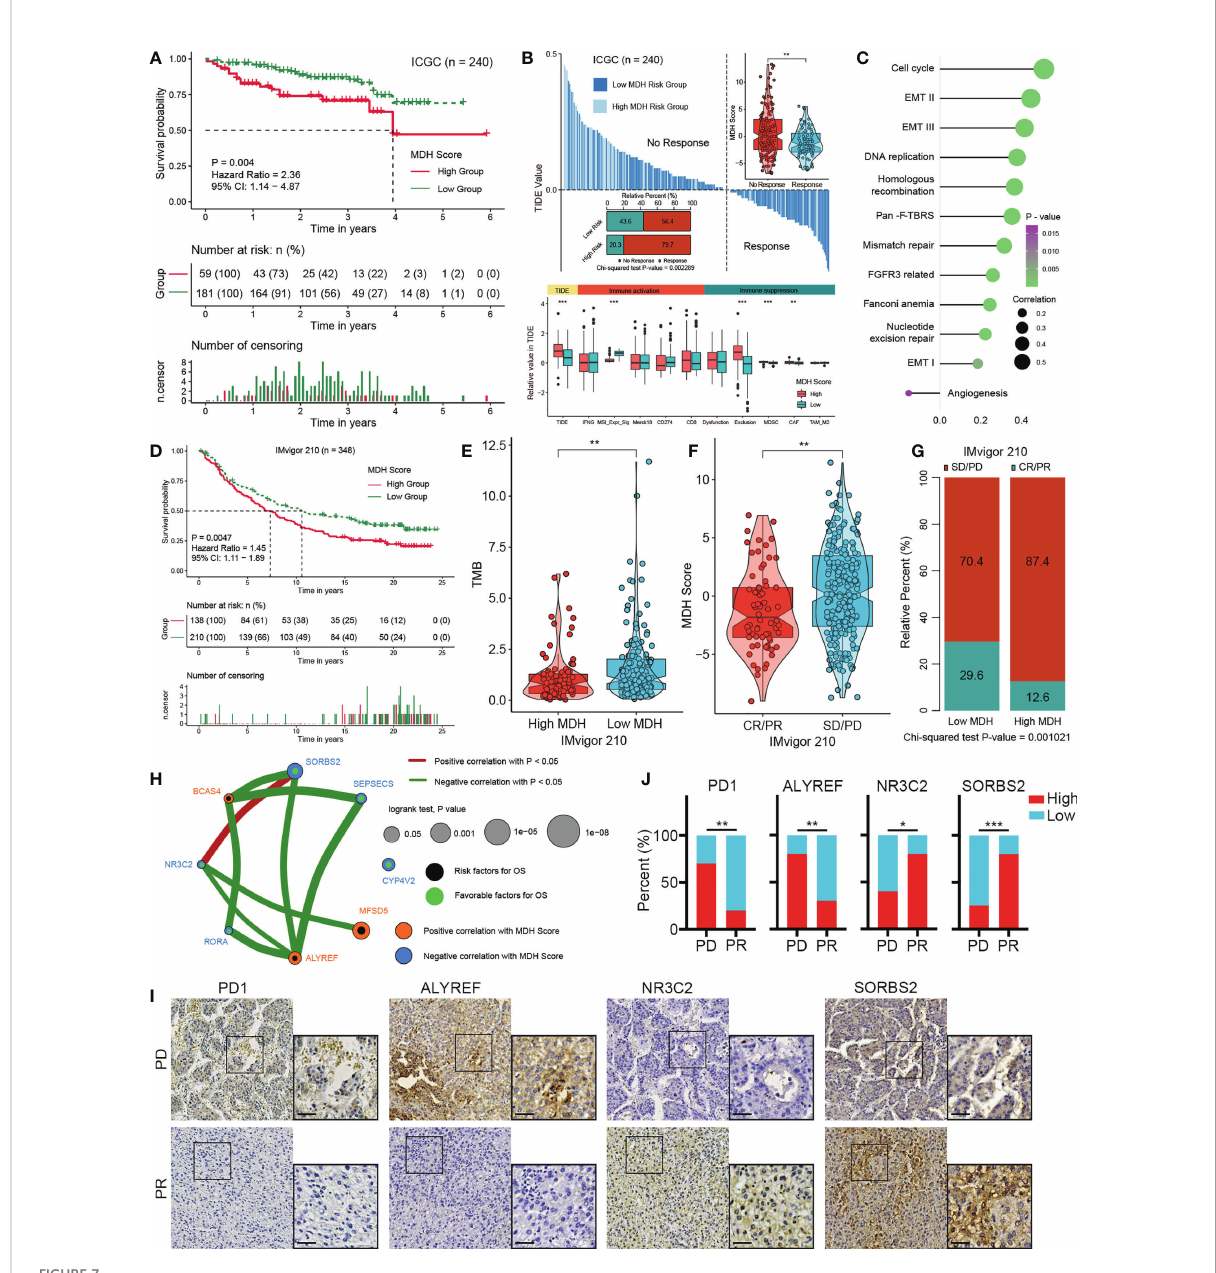
FIGURE 7 Validation of the MDH score for the immunotherapy response in HCC. (A) Survival analyses for MDH high- or low-score groups of the ICGC- LIHC cohort. (B) TIDE value of MDH high- or low-score groups in the ICGC-LIHC cohort. The chi-square test was used to calculate signi fi cant differences. (C) Differences expression of known signatures, including stromal activation-related signatures, tumour promotion-related signatures and immune activation-related signatures, in the MDH high- or low-score groups of the ICGC-LIHC cohort. (D) Survival analyses for MDH high- or low-score groups of the IMvigor210 cohort. (E) TMB score in the MDH high- or low-score groups of the IMvigor210 cohort. (F) MDH score in complete response/partial response (CR/PR) patients and stable disease/progressive disease (SD/PD) patients in the IMvigor210 cohort. (G) Correlation analysis of the MDH score with TKI response in the IMvigor210 cohort. The chi-square test was used to calculate signi fi cant differences. (H) The interaction between 8 hub genes in the MDH gene signatures of the TCGA-LIHC cohort. (I) Representative IHC images of PD1, ALYREF, NR3C2 and SORBS2 staining in sorafenib sensitive- and resistant- groups from our HCC cohort. Scale bar denotes 40 m m. (J) Correlation analysis of sorafenib sensitivity and the expression of speci fi ed proteins. The asterisks in B, E, F and J represent the statistical p-value (*P< 0.05; **P< 0.01 and ***P<